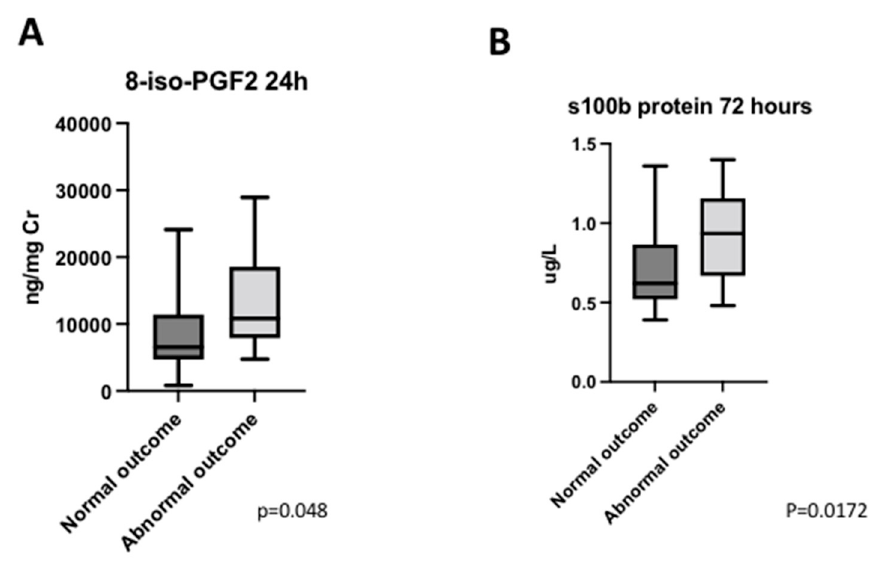
Figure 5. Neurological outcome. ( A ) Distribution of 8-iso-PGF2 levels 24 h after the surgery consider- ing neurological outcome. ( B ) Distribution of S100B protein levels 72 h after the surgery considering neurological outcome.